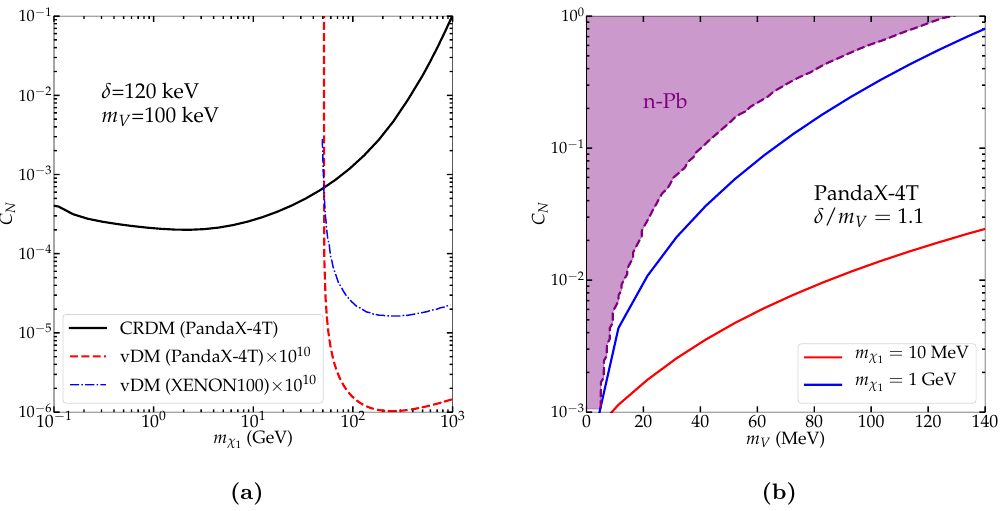
Figure 12. The 95% C.L. of PandaX-4T for both vDM (red dashed line) and CRDM (black solid line) in figure 12a. As a comparison, we translate the XENON100 95% limit [59] for vDM (blue dash-dotted line). We scale vDM limit with a factor 10 10 in order to compare it with CRDM in a same range. The mass splitting and mediator mass are taken as δ = 120 keV and m Figure 12b: the comparison to the previous n-Pb scattering limits [53] in the ( m purple region is the exclusion of n-Pb scattering experiment while the PandaX-4T CRDM limits are presented by blue line ( 1 GeV ) and red line ( 10 MeV ). With δ = 1 . 1 × m detection are more stringent than the previous n-Pb scattering